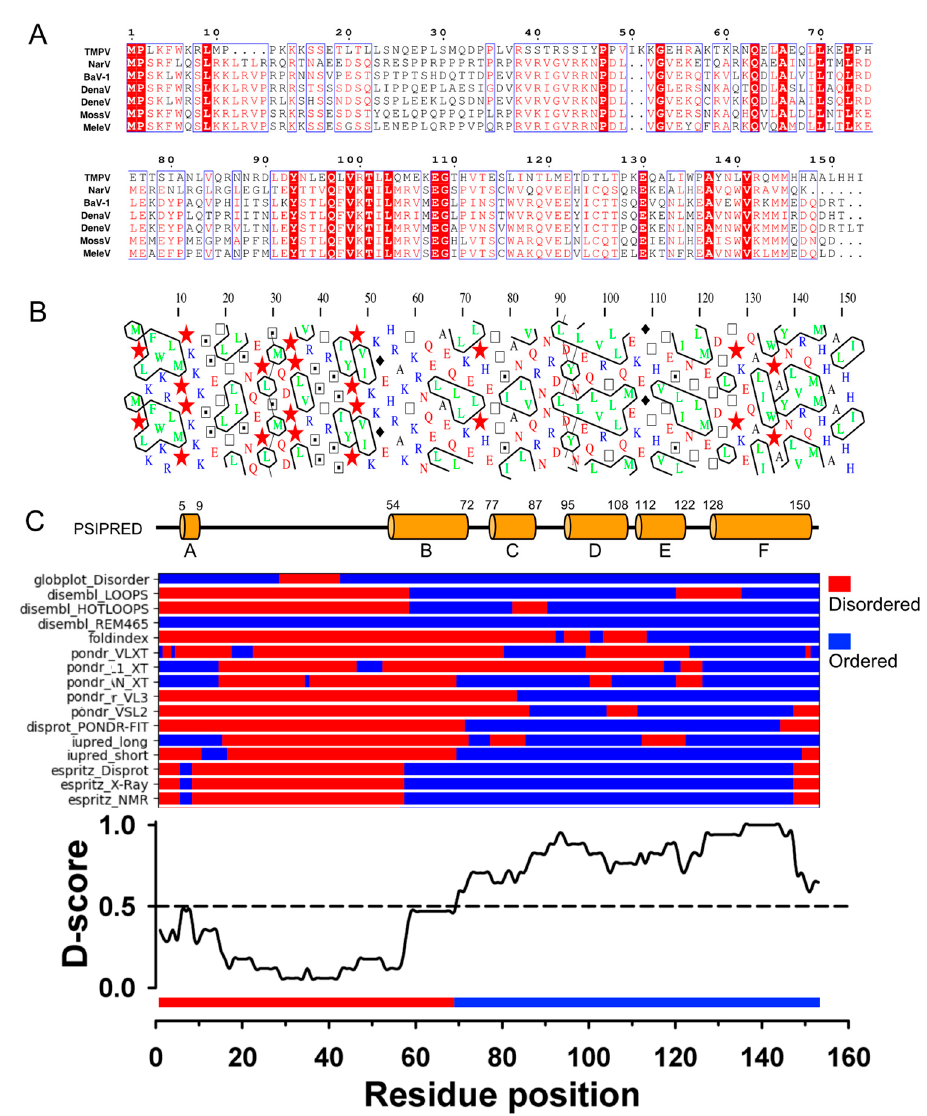
Figure 2. TupV C protein sequence analysis. ( A ) Multiple sequence alignment of Narmovirus C protein. Members of the Narmovirus genus and their UniProt accession number: TupV—Tupaia paramyxovirus—Q9WS38; NarV—Nariva narmovirus—B8XH61; BaV-1—Myodes narmovirus (Bank Vole virus-1)—A0A2H4PJ60; DenaV—Denalis virus—UQM99579; DeneV—Denestis virus— UQM99571.1; MossV—Q6WGM3; MeleV—Meleucus virus—UQM99623. ( B ) HCA (Hydrophobic Cluster Analysis) plot. ( C ) Secondary structure and disorder predictions. The upper part shows the secondary structure prediction from PSIPRED (the position of predicted helices is indicated by the orange cylinders with the residue numbers shown above). The middle part shows the predictions from individual predictors as obtained in the output of the D-score script. The lower part shows a consensus disordered prediction (D-score) calculated as described in [25]. The threshold to distinguish between ordered and disordered regions was set at 0.5.